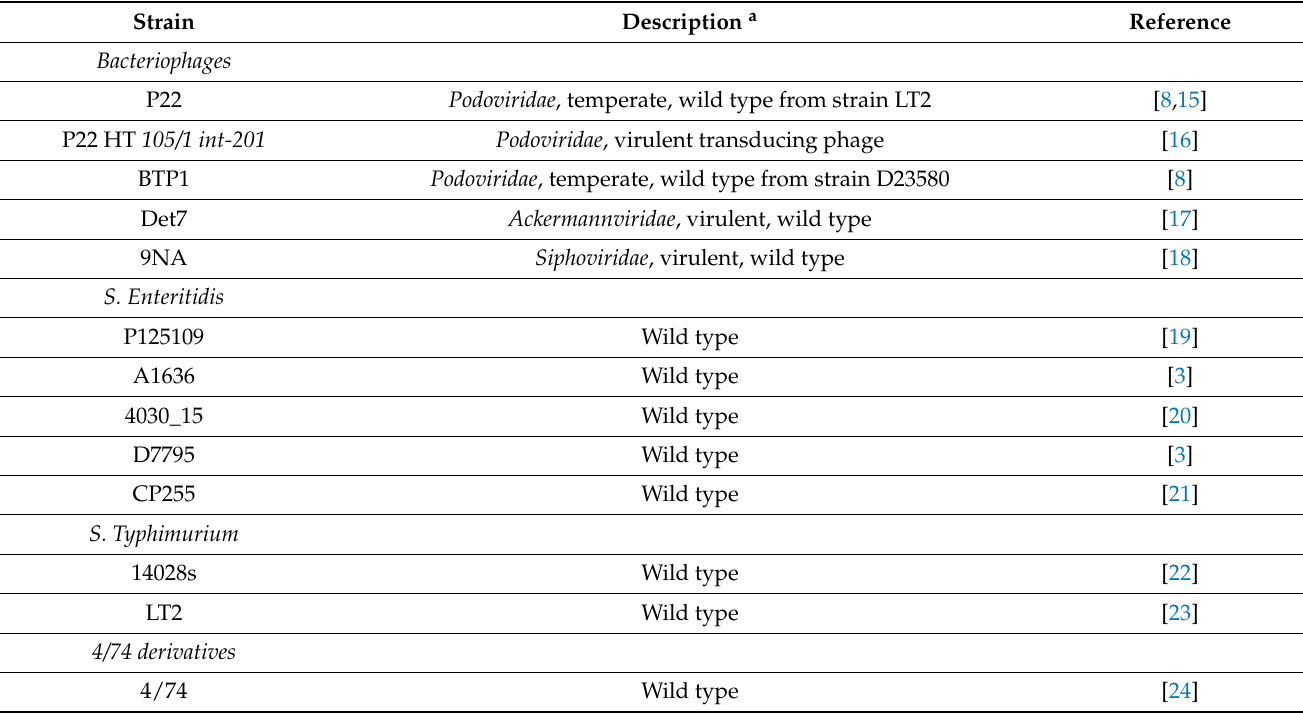
Table 1. Published bacteriophages, bacteria strains, and plasmids used in this study. Strain Description